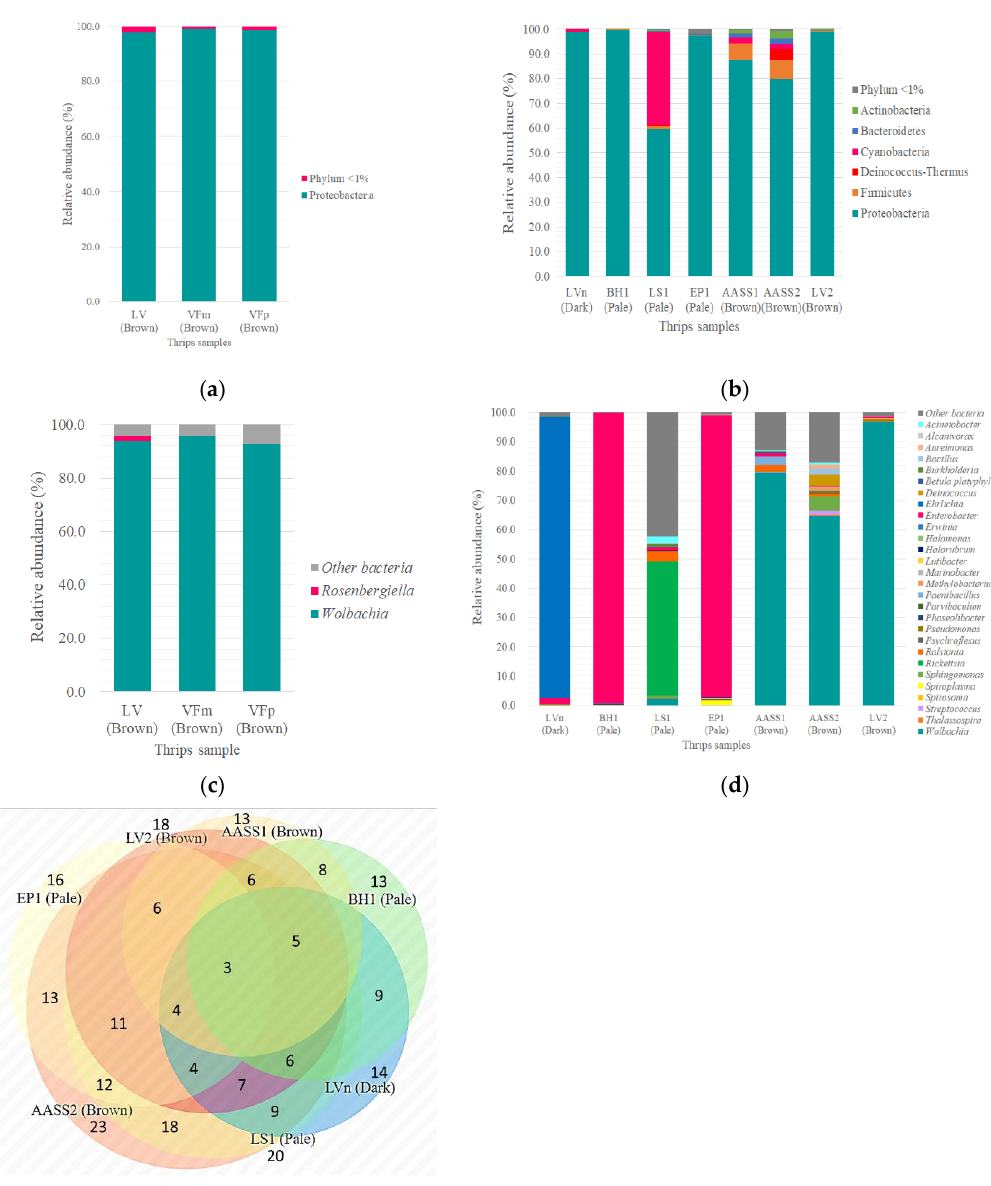
Figure 5. Relative abundance of bacterial OTUs at the phylum level found in ( a ) samples obtained from the sequencing of the V1 – V2 region of S. hansoni . ( b ) Sequencing of the V4 – V5 region of the samples of S. hansoni (brown), F. panamensis (dark morphotype), and Frankliniella (pale morphotype). Data are presented in percentages (%) for all sequences classified at this level of taxonomy. Relative abundance of bacterial OTUs at the genus level found for ( c ) samples obtained from the sequencing of the S. hansoni V1 – V2 region. ( d ) Sequencing of the V4-V5 region of the samples of S. hansoni (brown), F. panamensis (dark morphotype), and Frankliniella (pale morphotype). Data are presented in percentages (%) for all sequences classified at this level of the taxonomy. ( e ) Venn diagram shows the “core” at the genus level. Relative abundance of genera based on the data obtained using the metataxonomic approach of the Antioquia thrips samples. Venn diagram showing overlays of OTUs, where 3 OTUs were common for the three thrips morphotypes (dark, pale, and brown) evaluated. Nomenclature: LV, LV2 and LVn correspond to the La Vega farm, VFm and VFp to the Villa Fátima farm, AASS1 and AASS2 to San Sebastian, BH1 to Barahonda, LS1 to Luisines, and EP1 to the farm El Paraíso.